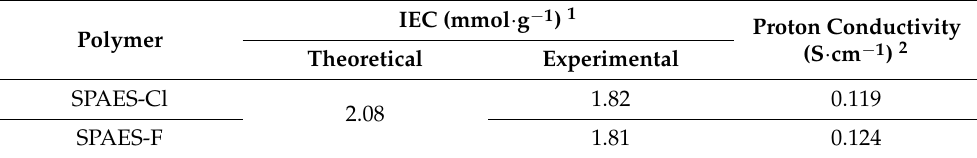
Figure 3. TEM images of SPAES copolymers; ( a ) SPAES-Cl and ( b ) SPAES-F. Table 1. IEC and proton conductivity of SPAES copolymer membranes.